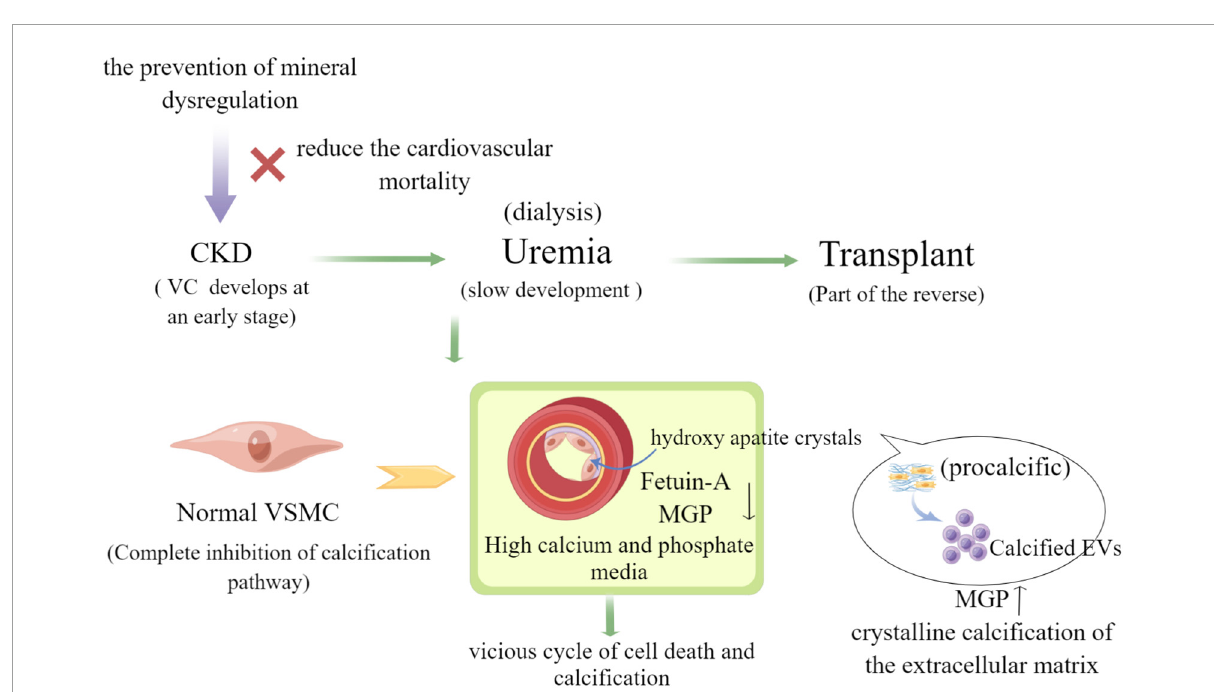
FIGURE3 The role of extracellular vesicles in vascular calcification in CKD (by